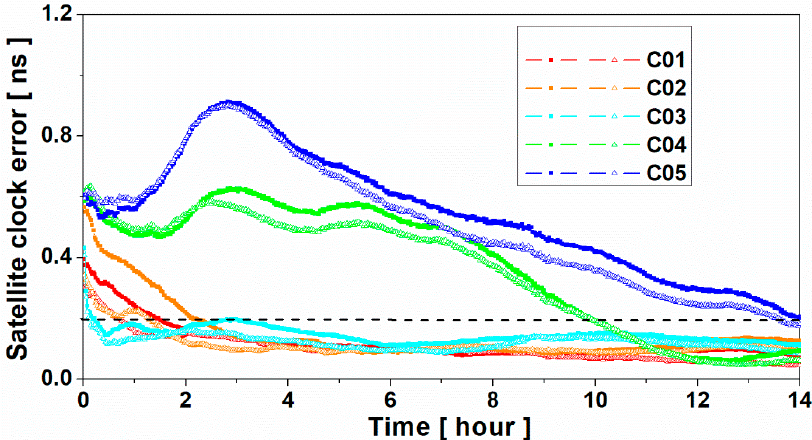
Figure 9. BeiDou Navigation Satellite System (BDS) satellite clock error time series without (line with solid square) and with (line with empty triangle) multipath correction.